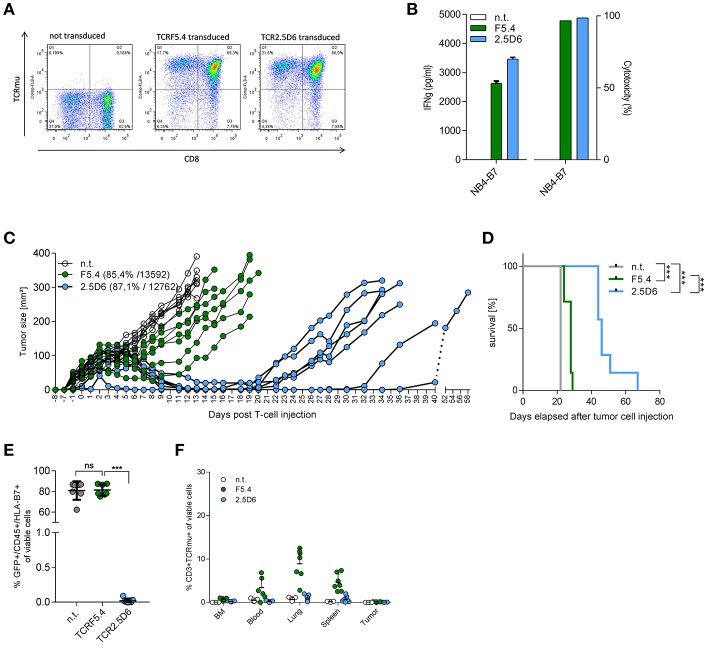
TCR2.5D6-transduced T cells show superior in vivo tumor killing efficacy. (A) FACS analysis of transduction efficacy for TCRF5.4- and TCR2.5D6-transduced T cells used for the long-term mouse experiment. The plots show pre-gated living CD3+ cells. X-axis represents the CD8 marker and Y-axis represents the TCRm+ T-cells. (B) Functionality of TCR-transduced T cells used for the long-term survival experiment of mice shown in (C) measured by IFN-γ release (right) and cytotoxicity (left) after co-cultivation for 24 h with NB4-B7 tumor cells in an E/T ratio of 1:1 in vitro. (C) Growth kinetic of NB4-B7eGFP tumors in NSG mice for a period of 58 days. Each line represents an individual tumor growth curve per mouse: n.t (n = 7), TCRF5.4 (n = 7), TCR2.5D6 (n = 7). (D) Kaplan Meier curve of mice shown in (C), ***p ≤ 0.0002. (E) Percentage of GFP+/HLA-B7+/NB4-B7eGFP tumors cell analyzed ex vivo by flow cytometry at individual time points after decease of mice shown in (C). Non-transduced (n = 7), TCRF5.4-transduced (n = 7) or TCR2.5D6-transduced T cells (n = 7), nsp ≥ 0.05, ***p = 0.0006. (F) Percentage of CD3+/TCRm+ living cells in BM, blood, lung, spleen, and tumor analyzed ex vivo by flow cytometry at individual time points after T-cell injection after decease of mice shown in (C). n.t (n = 7), TCRF5.4-transduced (n = 7) or TCR2.5D6-transduced T cells (n = 7). (C) Transduction efficiency and MFI of both TCRs are bracketed. (E) Significances are calculated by Mann-Whitney Test. (D) Survival statistics are calculated by Log-rank (Mantel-Cox) test.